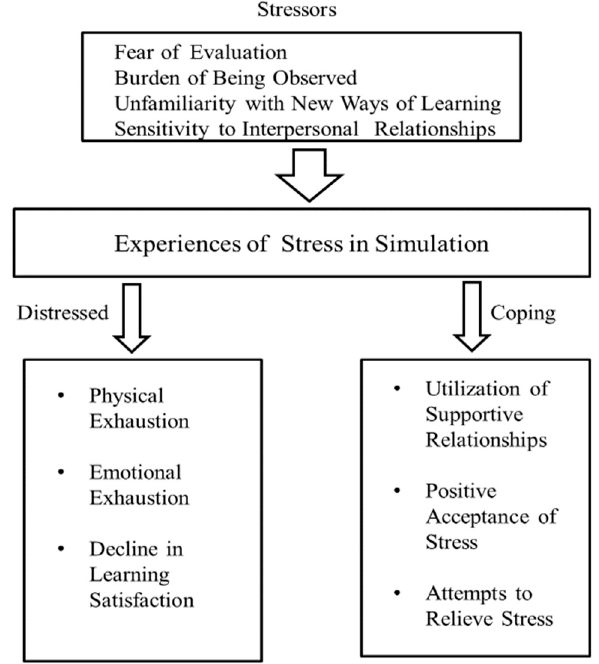
Figure 1. Conceptual framework: Nursing students’ experiences of stress in simulation-based learning .